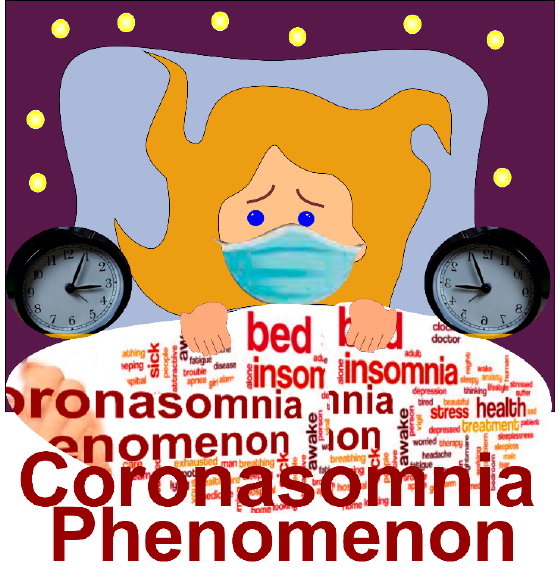
Figure 1. The ‘coronasomnia’ phenomenon has been recently described as COVID-19-related sleep disorders, including insufficient sleep, poor sleep quality, insomnia, and disturbances of sleep-wake schedules associated with physical and emotional morbidity in the COVID-19